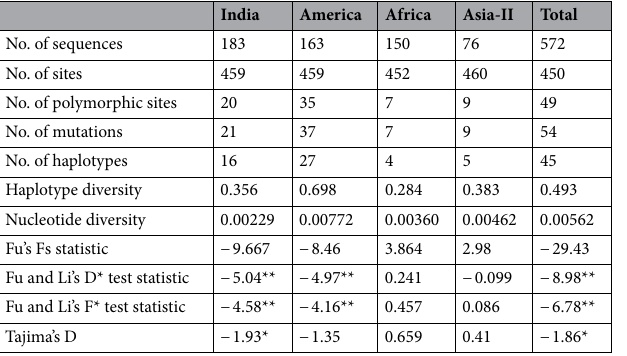
Table 1. Summary of the genetic diversity of FAW populations analysed on the basis of partial mtCOIA gene from four geographical locations viz. India, America, Africa and Asia-II. (** P < 0.02) (* P < 0.05).